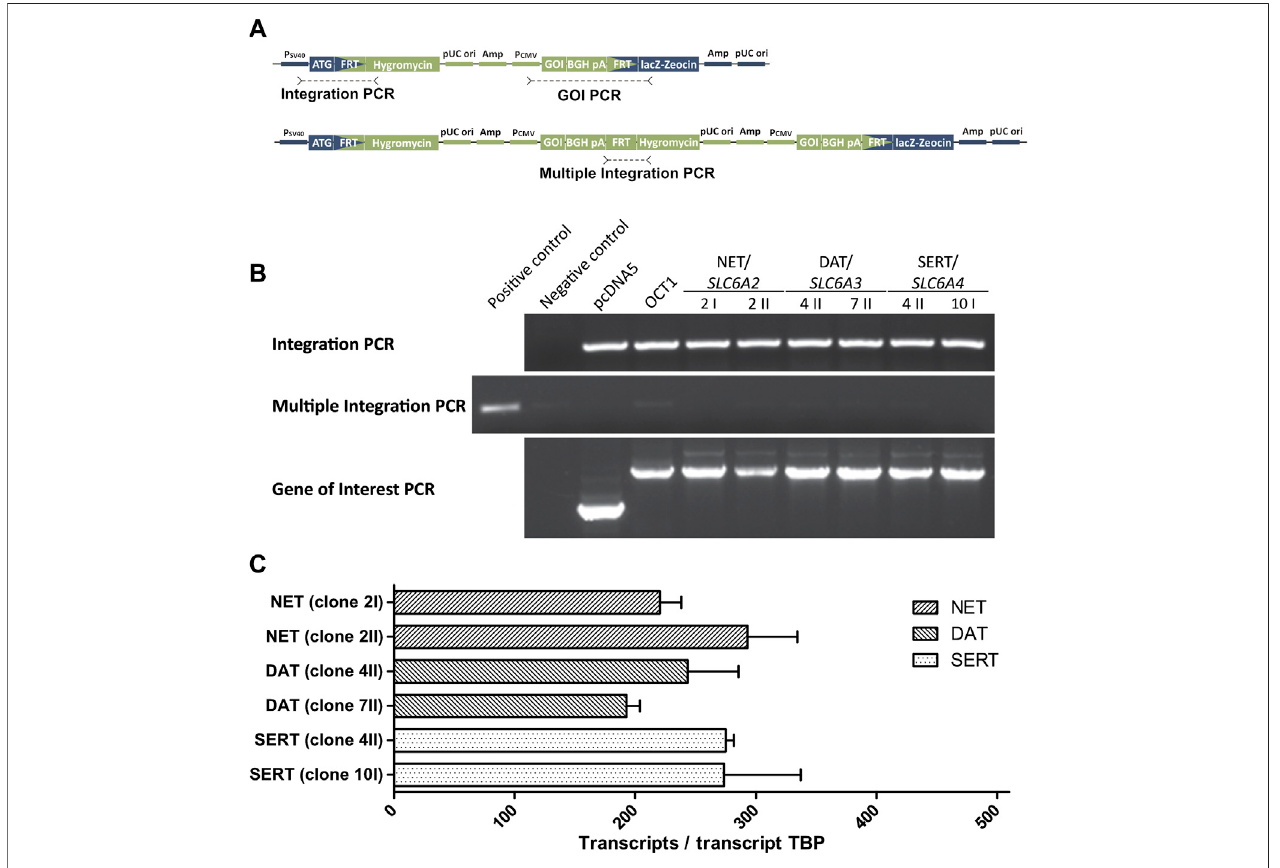
FIGURE 2 | Validation of HEK293 cell clones overexpressing monoamine neurotransmitter transporters (A) Schematic representation of the expression plasmid pcDNA5 (green) and the host cell line genome (blue) at the FRT site showing the target positions of the three conducted PCRs (B) Results of the three validation PCRs that show a successful integration (Integration PCR) for all newly created cell clones that overexpress the high-af fi nity monoamine transporters. The absence of ampliconsintheMultipleIntegrationPCRindicateasingleintegrationofthepcDNA5plasmid.Thecorrectnessofampli fi edgenesintheGeneofInterest (GOI)PCR wasvalidatedbySangersequencing (C) Quantitativereal-timePCRresultstocon fi rmcomparableoverexpressionofmonoaminetransporters,shownastranscriptsper transcript of the TATA-binding protein. Only one cell clone was selected per transporter for experiments.